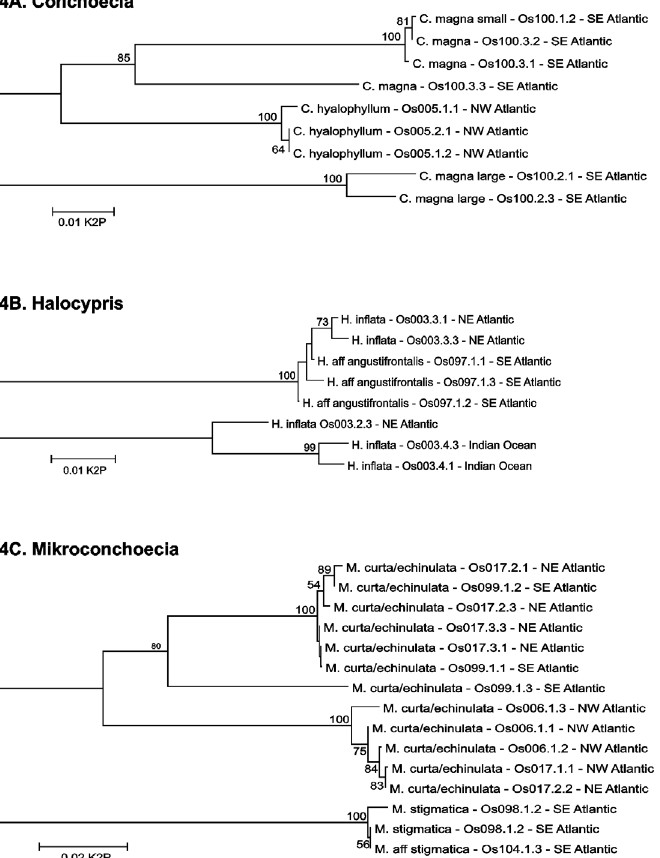
as explained in the legend to Fig